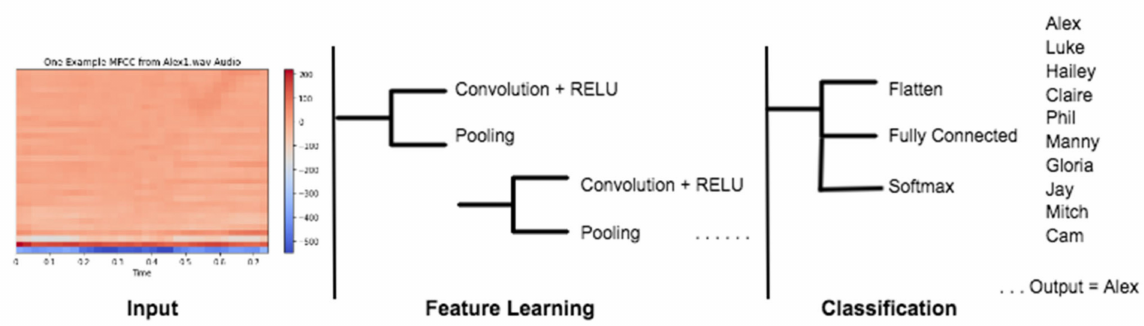
Figure 3. The process to train and classify the voices from Modern Family (Adapted from https://towardsdatascience.com/ a-comprehensive-guide-to-convolutional-neural-networks-the-eli5-way-3bd2b1164a53, accessed on 5 June 2020).